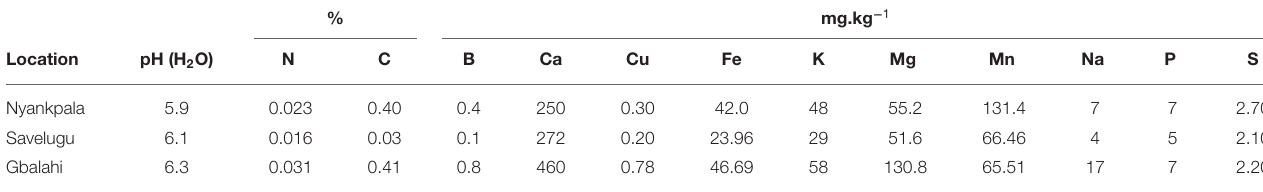
TABLE 1 | Soil chemical properties of the three test locations before planting.